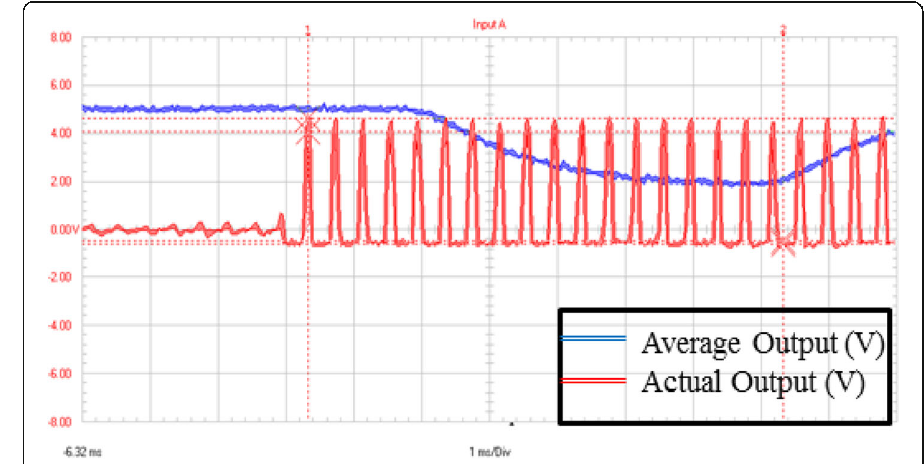
Fig. 6 Screenshot of speed sensor tachometer